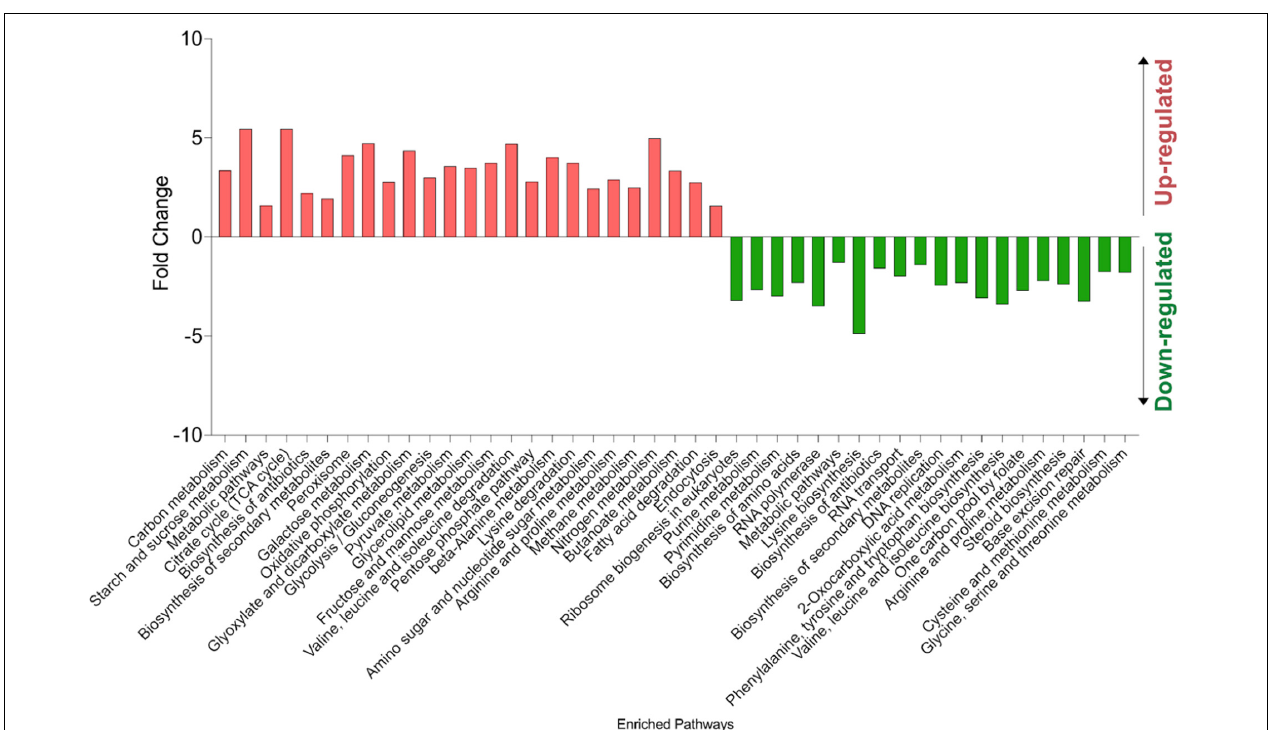
FIGURE 10 | KEGG pathway analysis results of up- and down-regulated genes in the oxidative stress-resistant evolved strain H7, compared to the reference strain. The experiments were performed as three biological